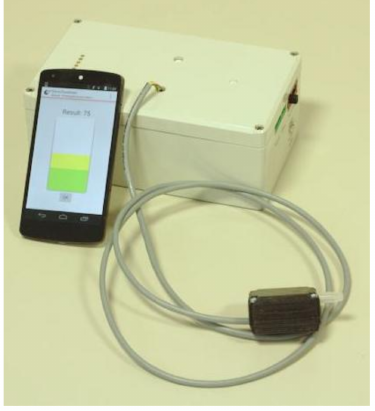
Figure 1. Pre-release Version of the Mobile Sensor System.